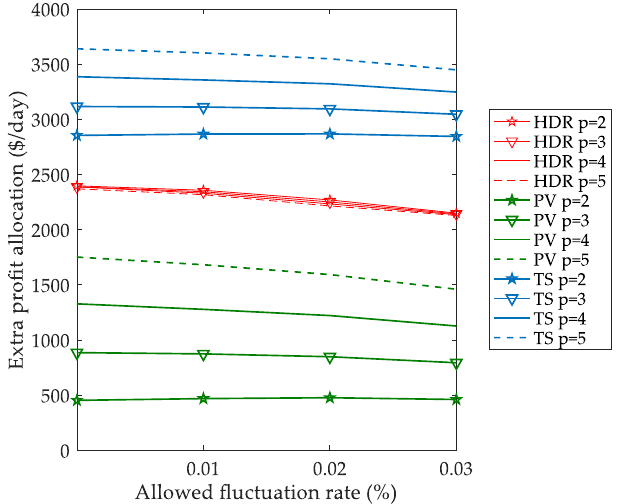
Figure 11. The extra profits allocation of HDR - TS-PV coalition.